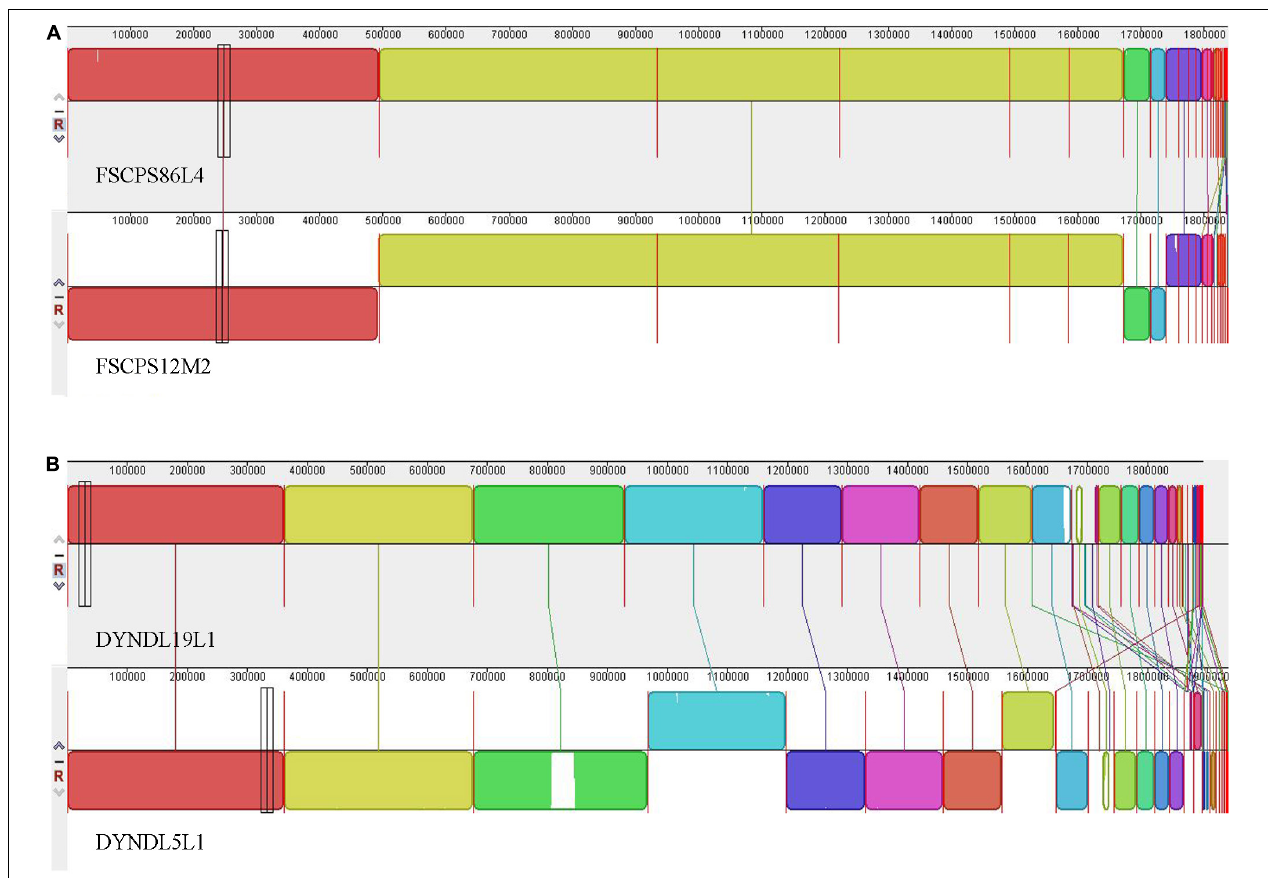
FIGURE 6 | The multiple genome alignment. (A) The multiple genome alignment between FSCPS86L4 and FSCPS12M2. (B) The multiple genome alignment between DYNDL19L1 and